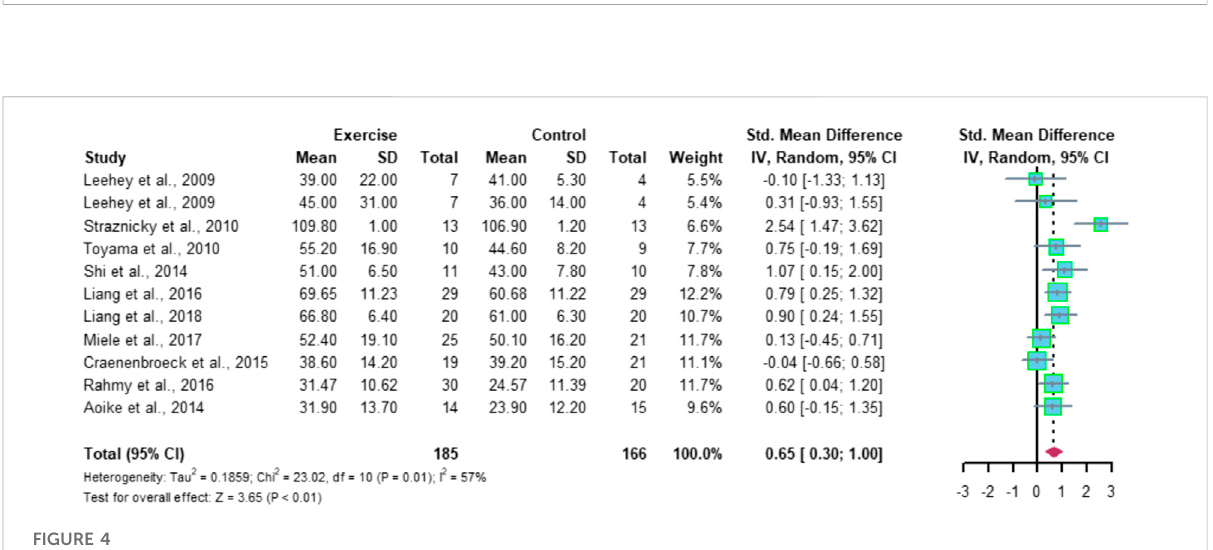
Meta-analysis of the effect of aerobic exercise on